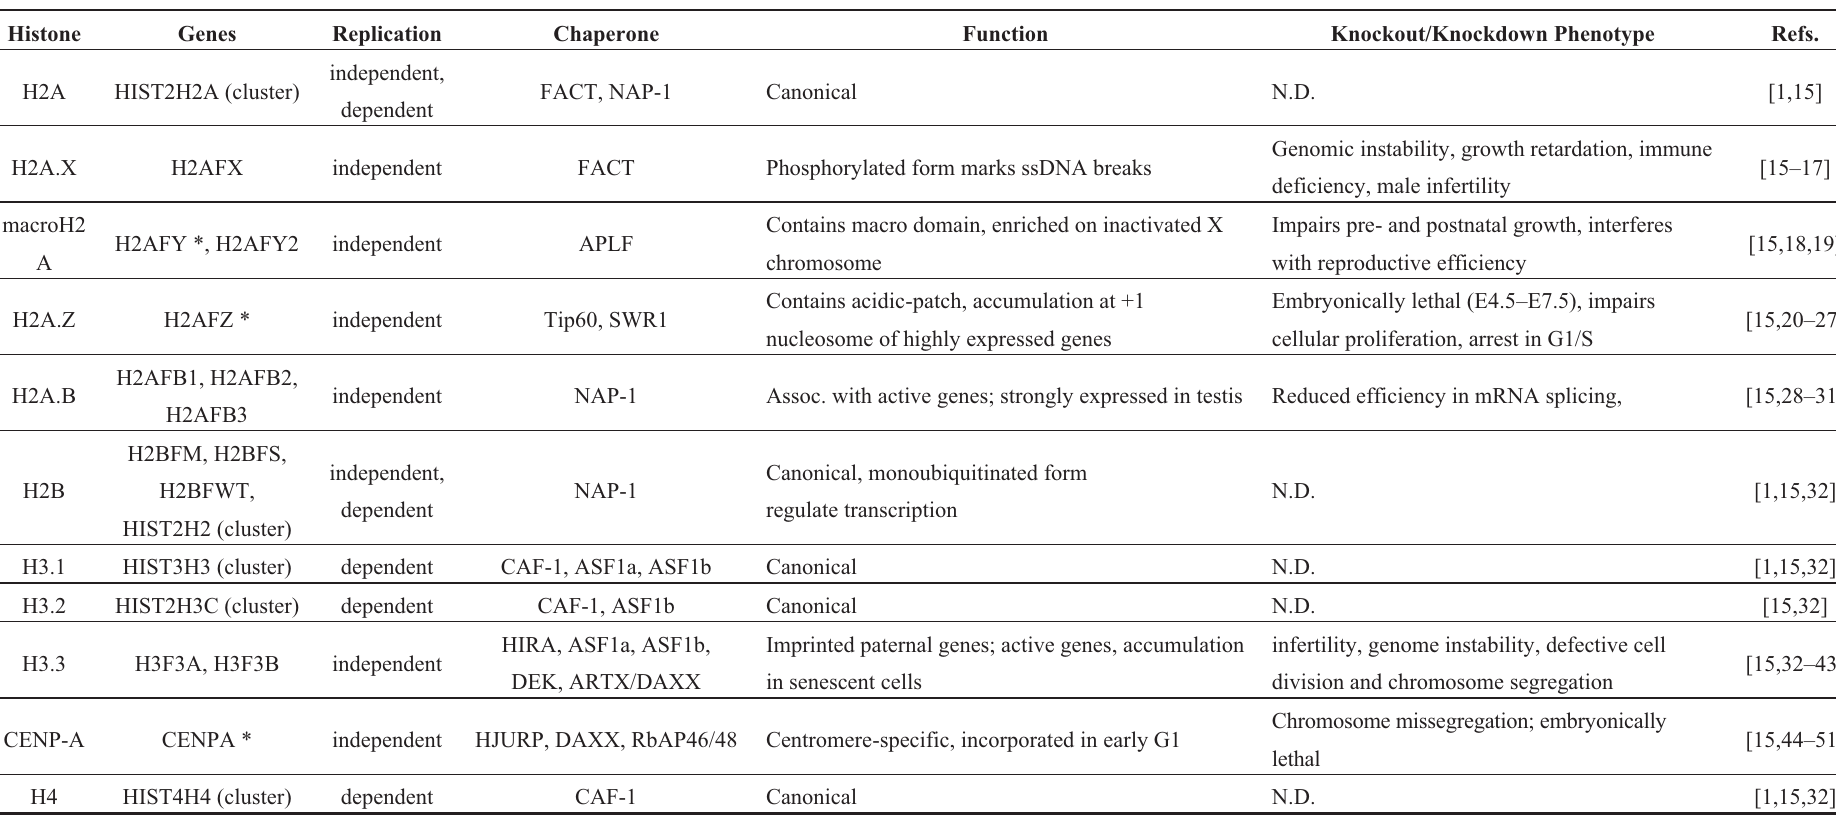
Table 1. Major histone variants in humans. For each major histone variant, the gene or gene clusters are reported, as well as its dependence on replication, its chaperone, distinctive functional features, and knock-out or knock-down phenotypes. * Genes encoding splice